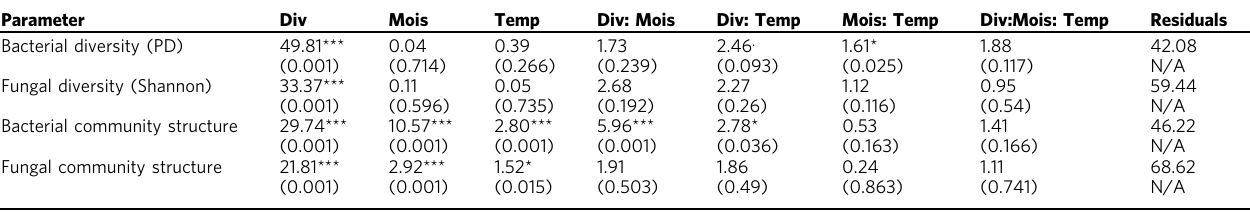
Table 1 Percentage of variance explained by the diversity manipulations (Div), moisture (Mois) and temperature (Temp) treatments, and their interactions for bacterial and fungal alpha diversity metrics and bacterial and fungal community structure. Parameter